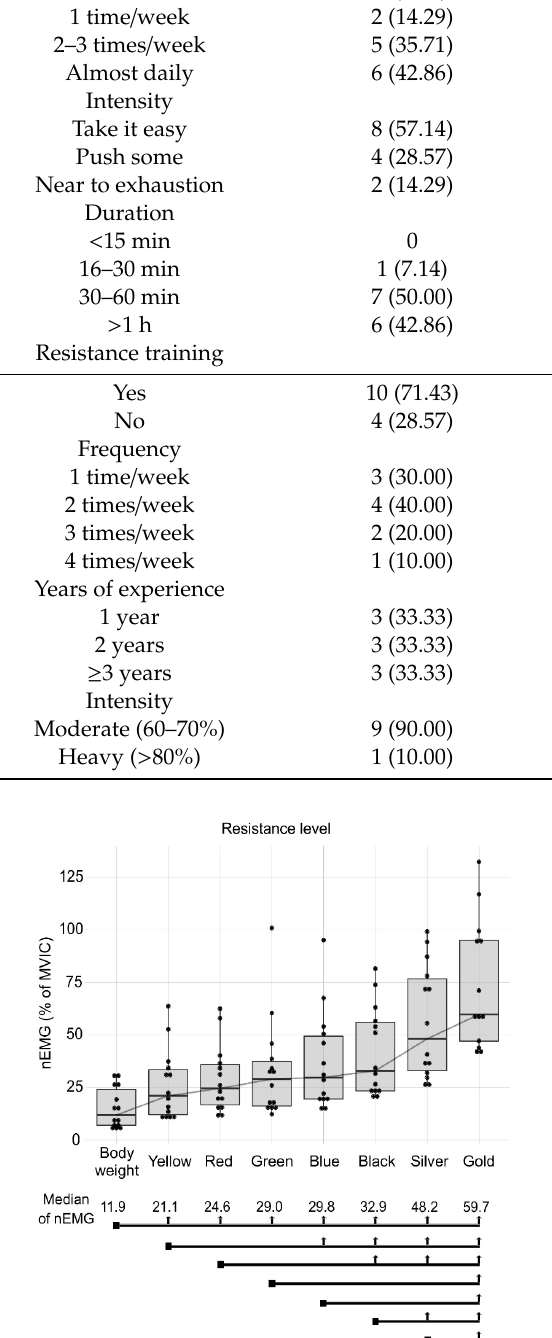
Figure 2. Median muscle activation (Median of nEMG) of RF muscle in the different conditions: body weight, yellow, red, green, blue, black, silver and gold elastic band. The square point at the beginning of the black line marks the compared condition and the vertical arrows show significant differences between conditions.